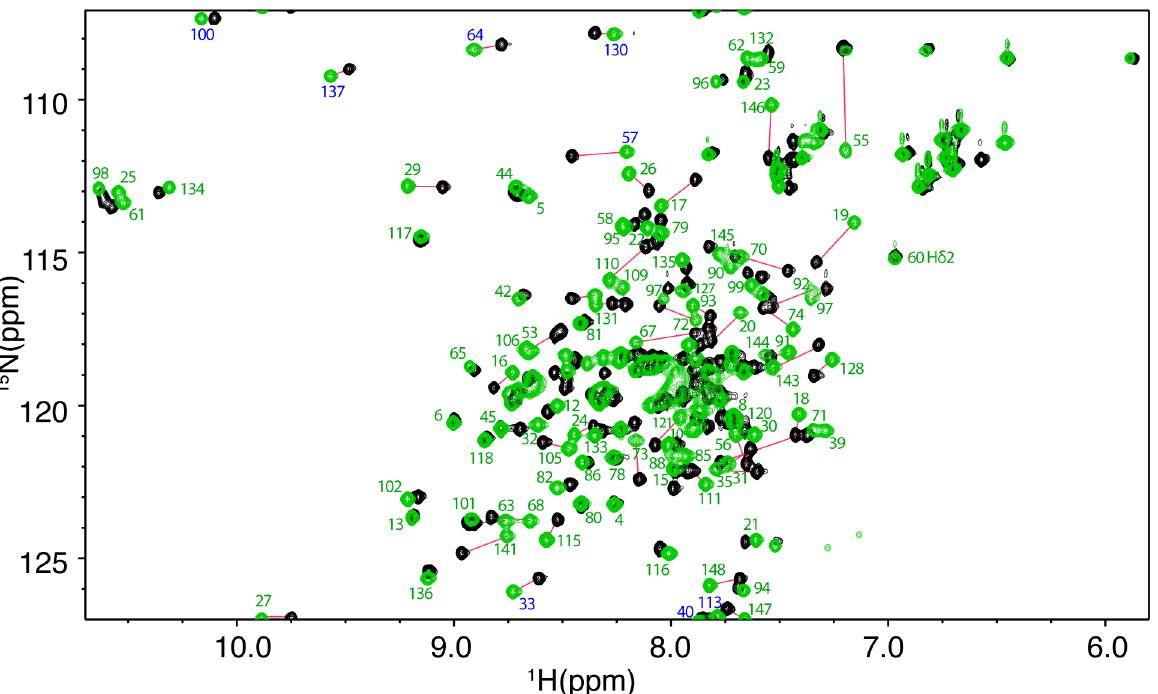
Fig 6. 2D HSQC NMR data for Ca 2+ /CaM:Fas-Pep2 complex. Overlay of 2D 1 H- 15 N HSQC spectra obtained for 15 N-labeled Ca 2+ /CaM in the free state (black) and in complex with Fas-Pep2 (green) at 1.5:1 peptide:CaM ratio. No chemical shift changes were observed in the HSQC spectra with further addition of Fas-Pep2, indicating saturation at this ratio. Signal labels correspond to residues of CaM in the bound form. Signals labeled in blue are folded in the spectrum by 20 ppm.